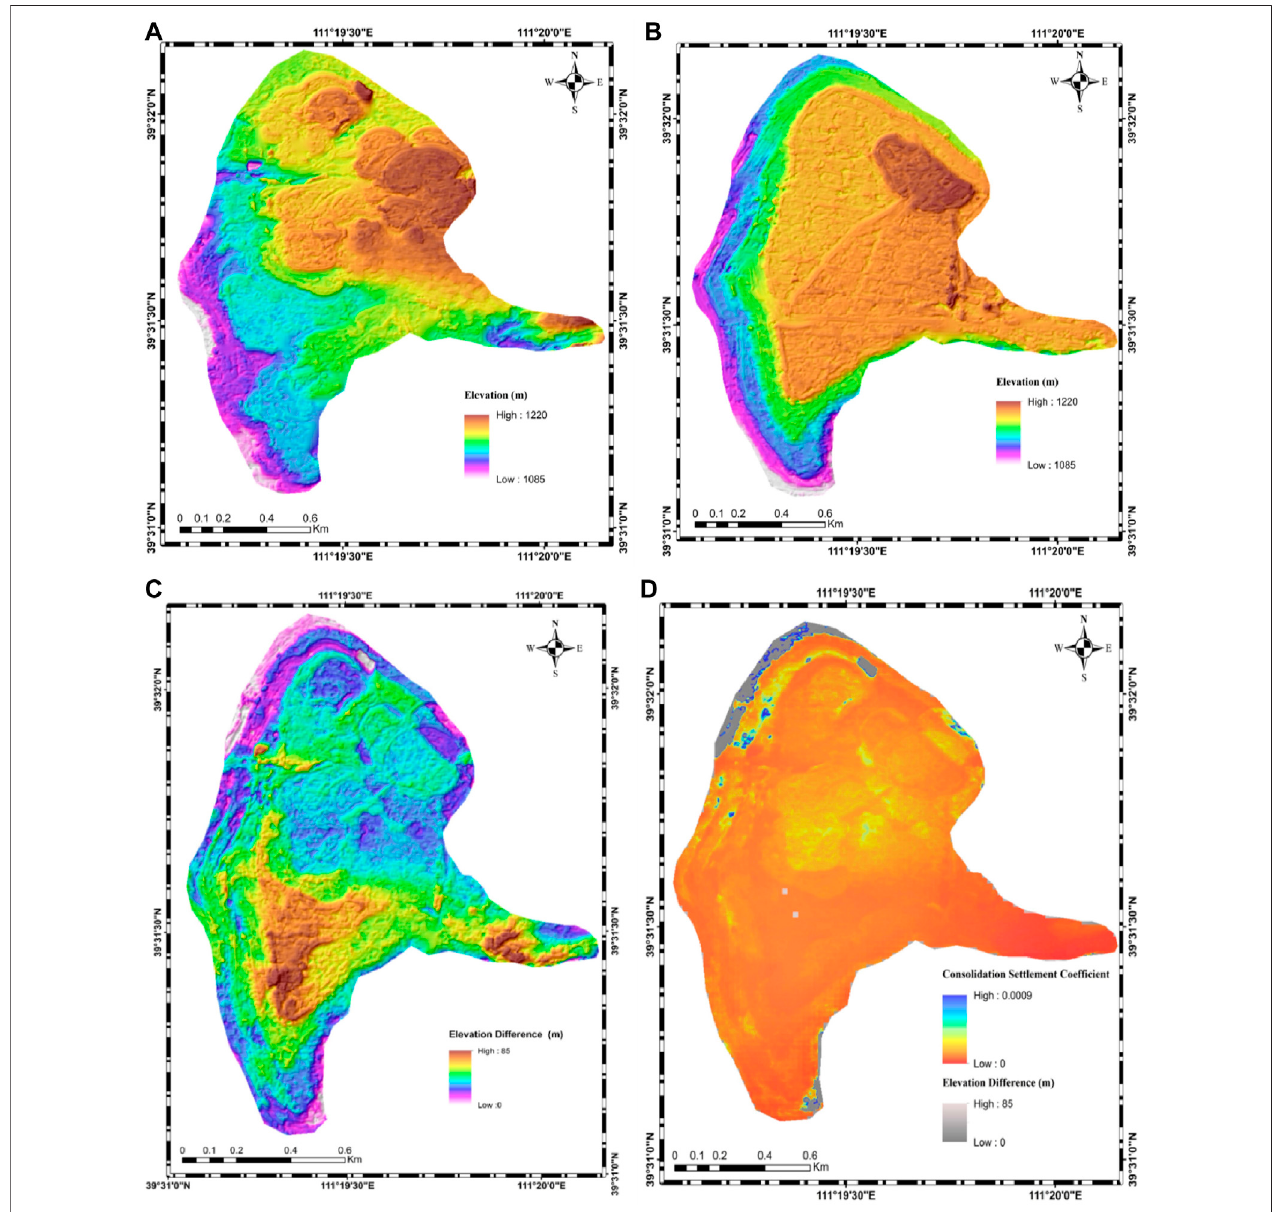
FIGURE6|(A,B) arethegeneratedDEMsintheyears2012and2019; (C) Soilthicknessoftheminewastedumpestimatedbycalculatingthedifferenceofthetwo co-registered ZY-3 DEMs in the years of 2012 and 2019, respectively; (D) Estimated parameters of the secondary consolidation model and its background is the elevation difference between the years 2012 and